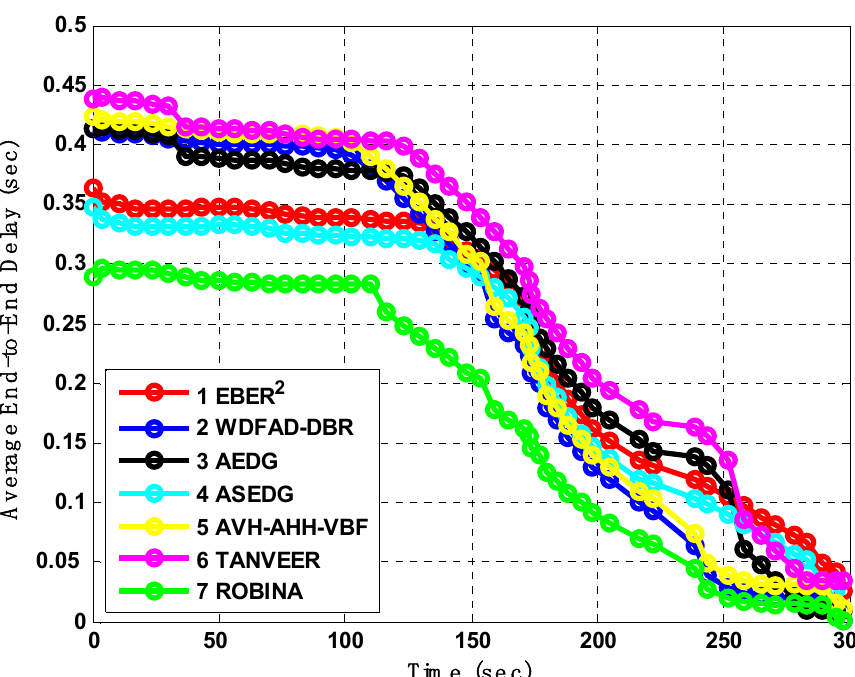
Figure 8. Analysis of Packet transmission with baseline schemes.